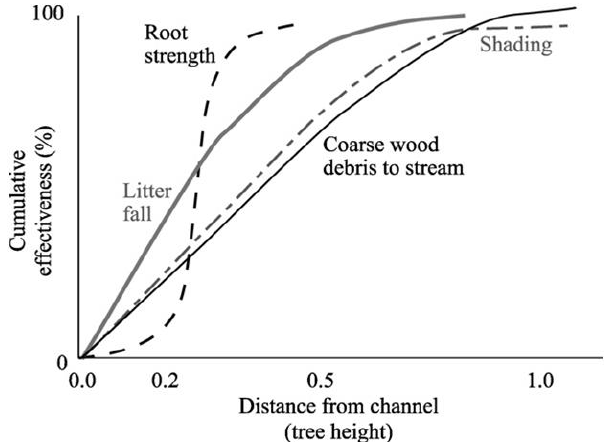
Figure 1. Generalized curves indicating percent of riparian ecological functions and processes occurring within varying distances from the edge of a stream channel into forested uplands (Adapted from